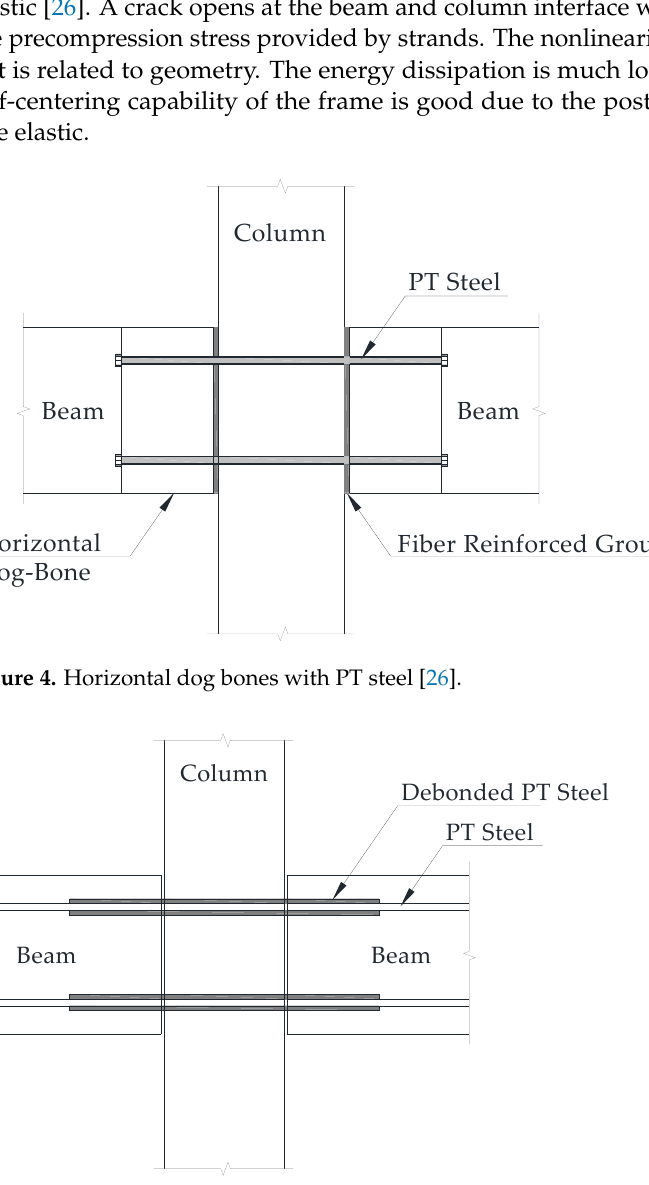
Figure 3. Example of connection with friction plates [26].